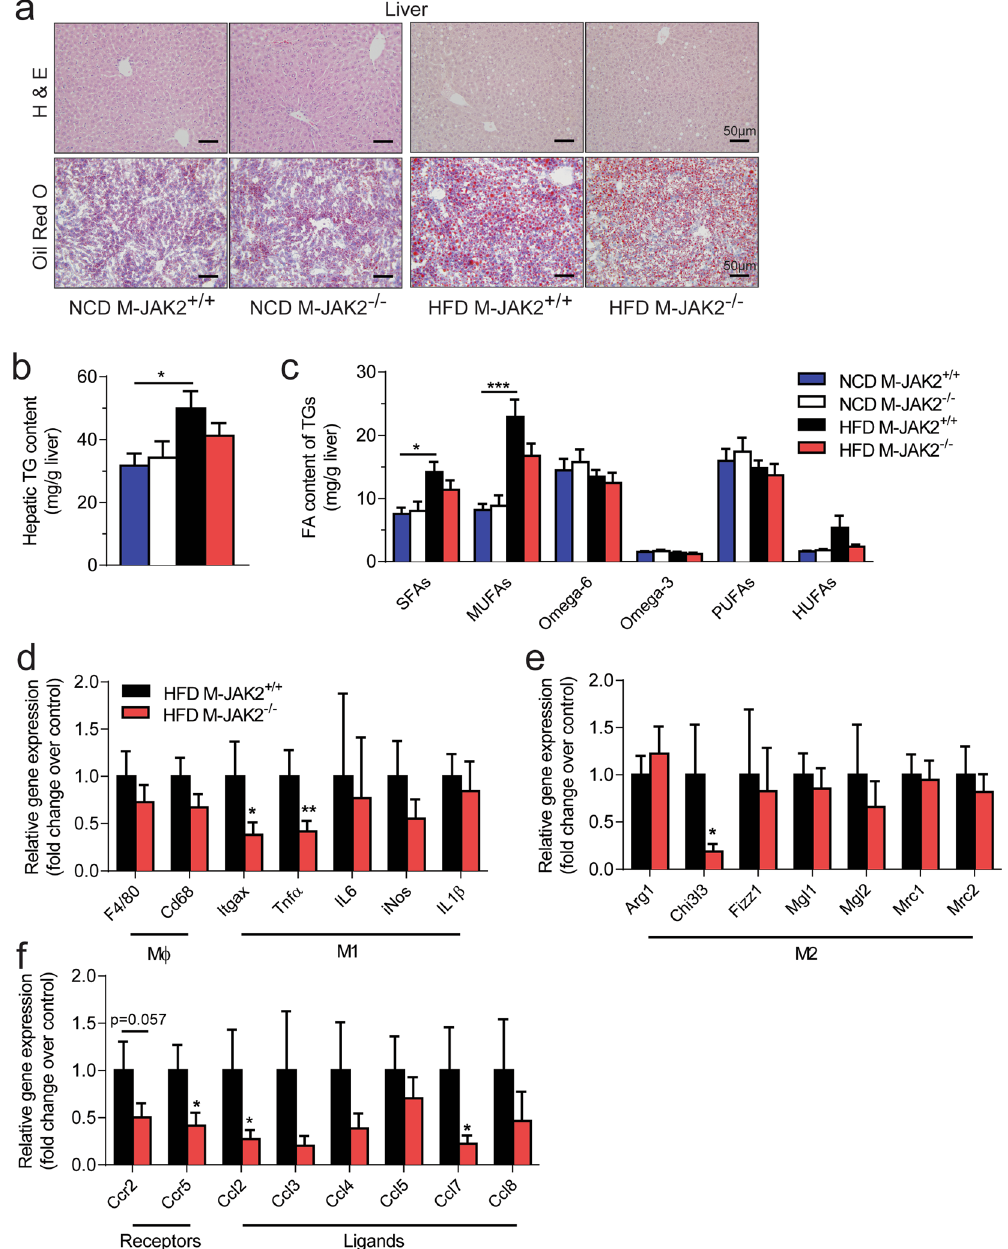
Figure 5. Reduced hepatic inflammation in HFD fed M-JAK2 − / − mice. ( a ) Representative micrographs of H&E (top) and Oil Red O (bottom) stained liver sections from NCD or HFD fed M-JAK2 + / + and M-JAK2 − / − mice. Quantification of ( b ) total triacylglycerol (TG) levels and ( c ) amount of saturated (SFAs), mono-unsaturated (MUFAs), Omega-6, Omega-3, polyunsaturated (PUFAs) and highly unsaturated (HUFAs) fatty acids (FA) of TGs in liver from NCD- (n = 4–6) and HFD- (n = 9–10) fed M-JAK2 + / + and M-JAK2 − / − male mice. mRNA expression in liver from HFD-fed M-JAK2 + / + and M-JAK2 − / − mice for ( d ) macrophage (M φ ) and M1 markers, ( e ) M2 markers, and ( f ) chemokine receptors and its associated ligands (n = 8–9). All results are mean ± SEM; * p < 0.05, ** p < 0.01, *** p <